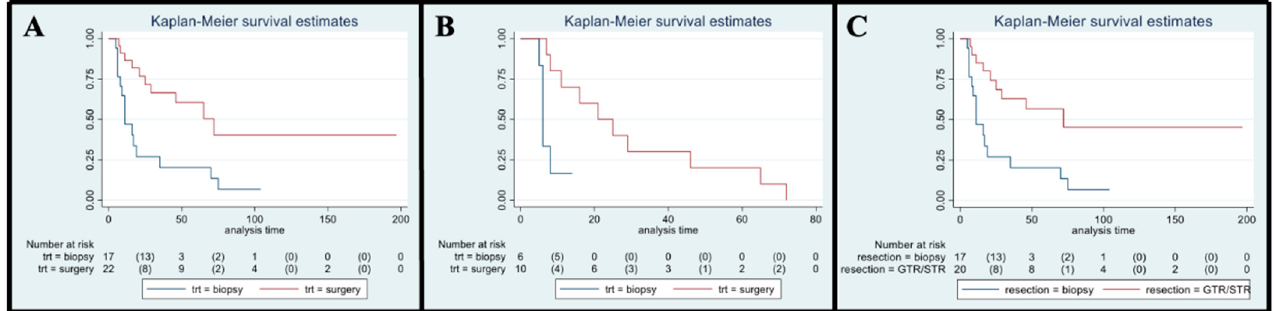
Table 2. Molecular characterization of LGG and HGG with survival estimates. SG and BG samples